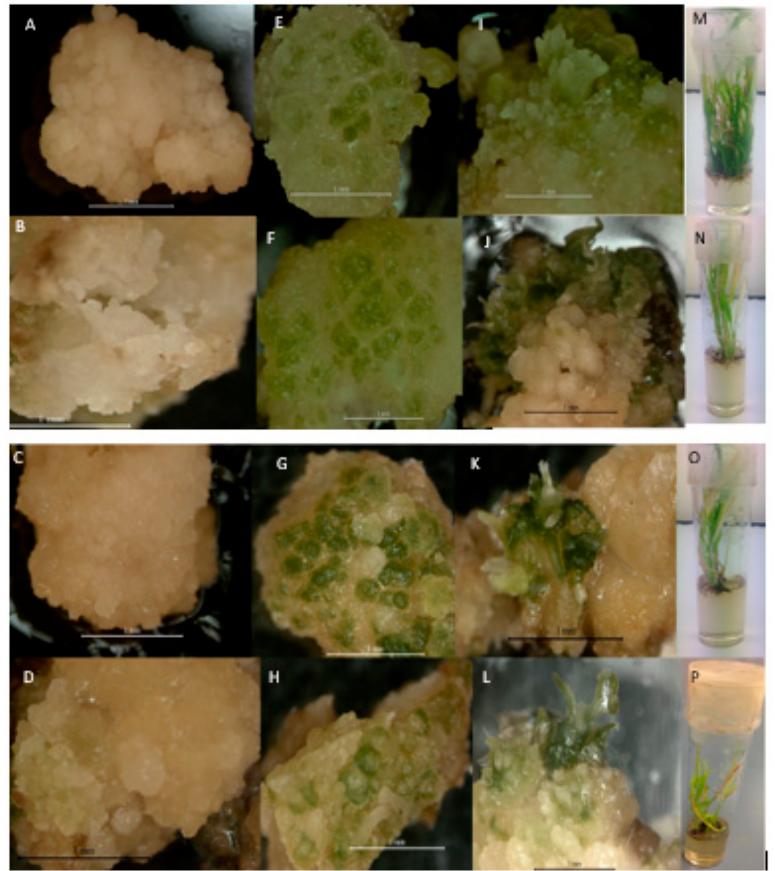
Figure 8. Plant regeneration through somatic embryogenesis of four Oryza sativa indica rice varieties which were derived from MS medium supplemented with 3 mg/L 2,4-D and 30 g/L maltose. A – D : Morphological features of callus on regeneration media under light microscope after 10 days of regeneration; E – H : green spot initiation after 21 days of regeneration; I – L : regenerated shoot; M – P : plantlet regeneration of MR220, MR220-CL2, MR232, and Bario respectively. Bar: 10 mm ( A – L ); and Bar: 1 mm ( M – P ).